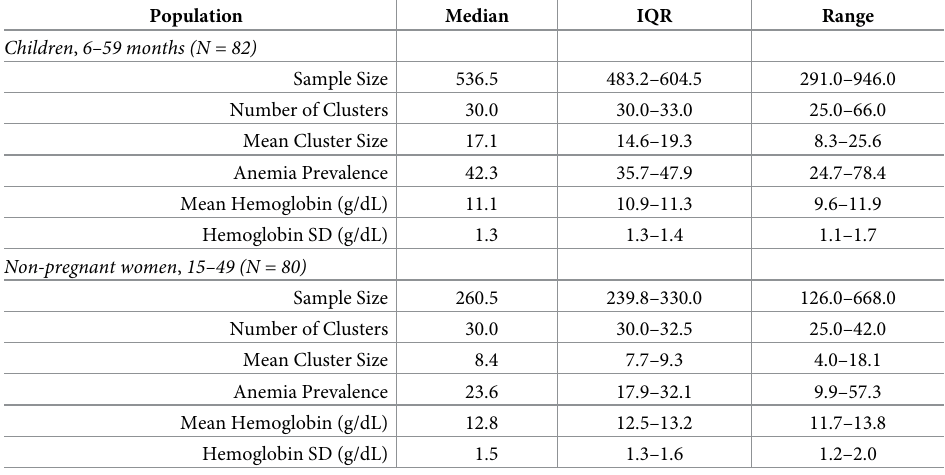
Table 2. Survey-level distribution of sample sizes, anemia prevalence, and hemoglobin standard deviations for non-pregnant women and young children two-stage, cluster surveys.